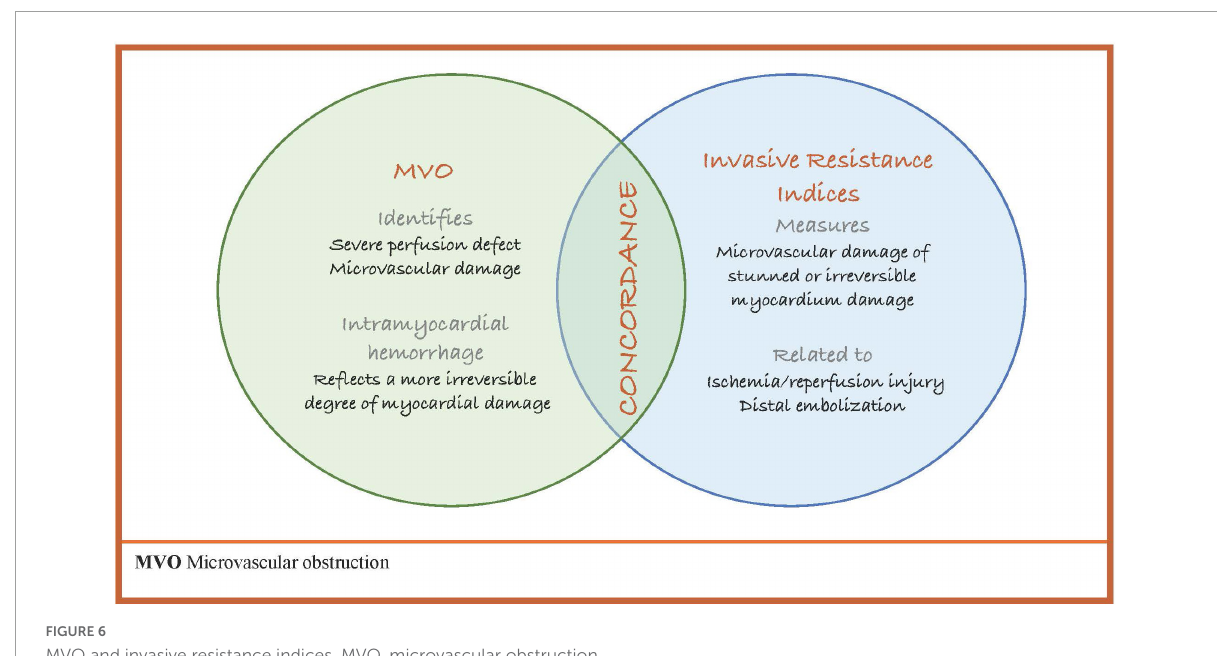
FIGURE6 MVO and invasive resistance indices. MVO, microvascular